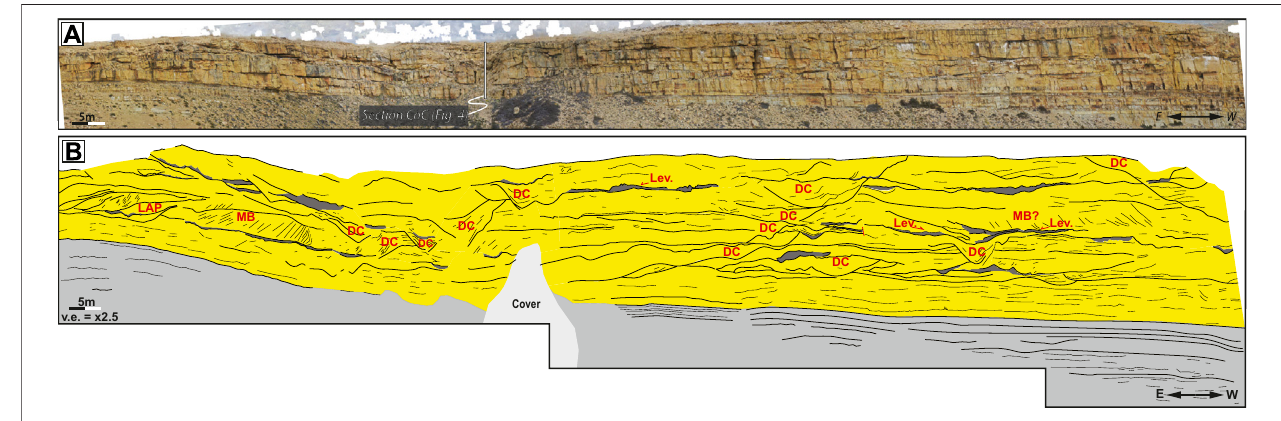
FIGURE 7 | (A) Photo-orthomosaic of a La Anita Formation cliff face where section CoC was measured. (B) Vertically exaggerated (x2.5) interpretation of above photo-orthomosaic with labeled distributary channels (DC), mouth bars (MB), levees (lev.), and lateral accretion packages (LAP). Yellow units are sandstone dominant, gray units are recessive and mudstone